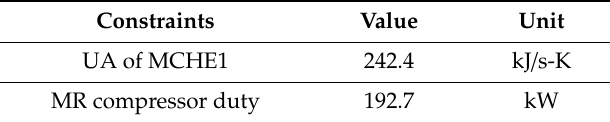
Table A1. Additional constraints for SMR.